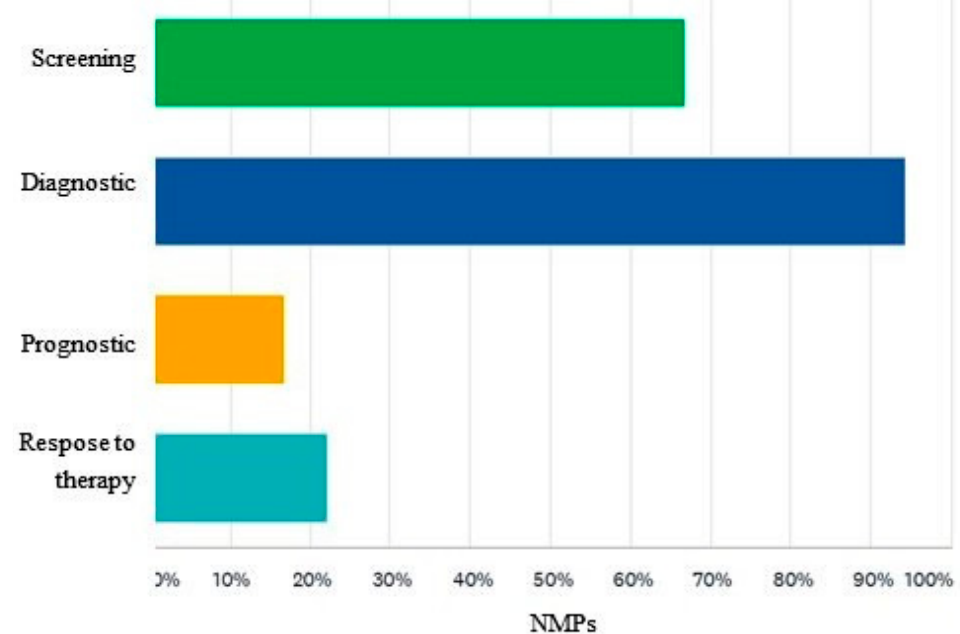
Figure 6. Perception of bisphosphonate scintigraphy clinical indications in amyloidosis management among NMPs. NMPs = nuclear medicine physicians.